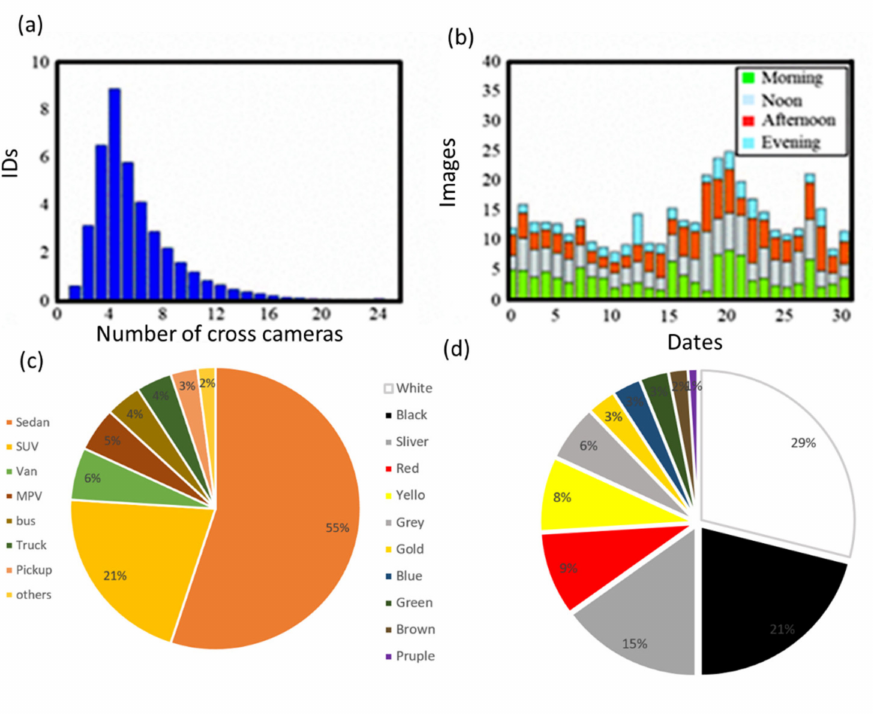
Figure 26. Illustrates the characteristics of VERI-Wild dataset. ( a ) The number of identities across multiple surveillance cameras; ( b ) Total number of IDs captured in different slots of each day; ( c ) Division of vehicle types; ( d ) Division of vehicle